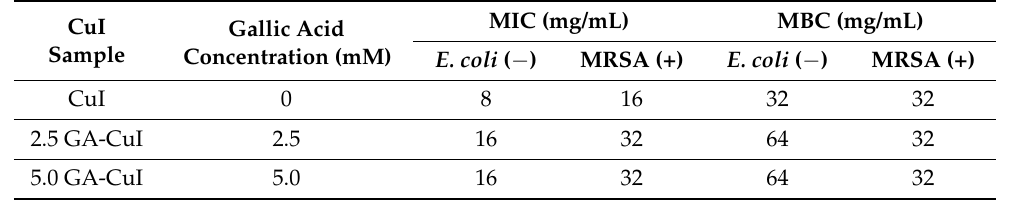
Figure 7. Bacterial growth after treatment with different synthesized CuI NPs for each bacterial strains: ( a ) E. coli treated with CuI; ( b ) MRSA treated with CuI; ( c ) E. coli treated with 2.5 GA-CuI; ( d ) MRSA treated with 2.5 GA-CuI; ( e ) E. coli treated with 5.0 GA-CuI; ( f ) MRSA treated with 5.0 GA-CuI. Table 2. Minimum inhibitory concentration (MIC), minimum bactericidal concentration (MBC) and ratio of CuI NPs for each bacterial strain.